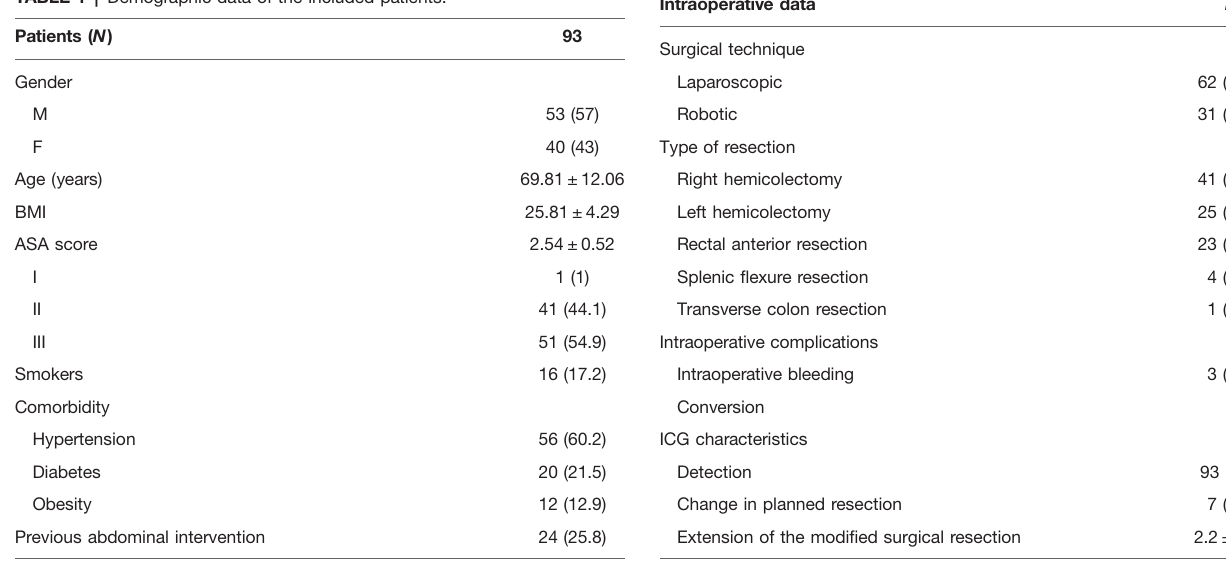
TABLE 1 | Demographic data of the included patients.